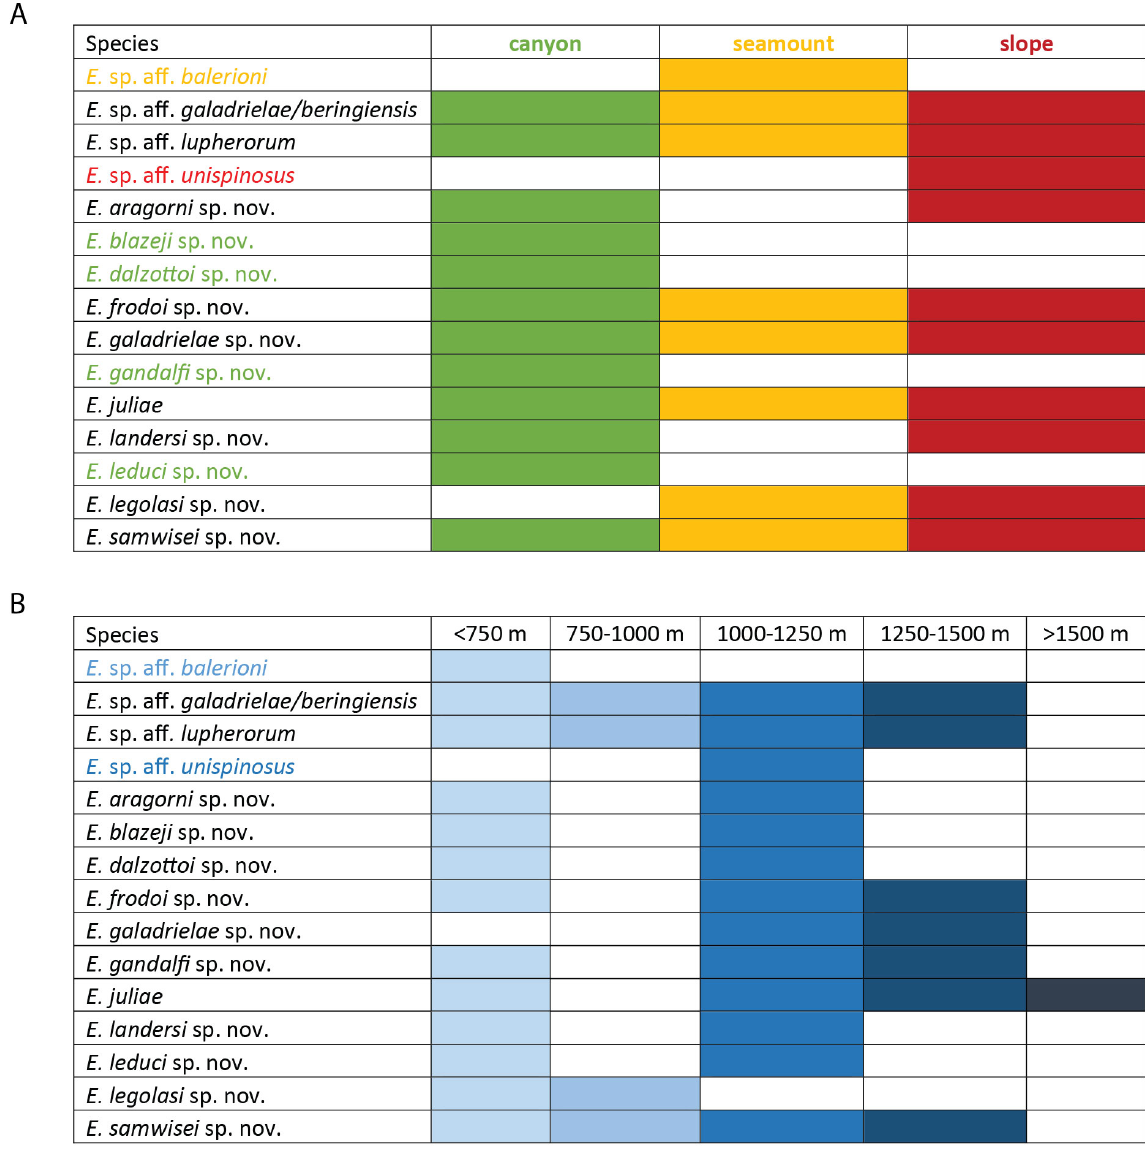
Fig. 40. Distribution of species of Echinoderes Claparède, 1863 according to (A) habitat type and (B) depth range. Species that occur only in one habitat type or at one depth range are highlighted in the corresponding